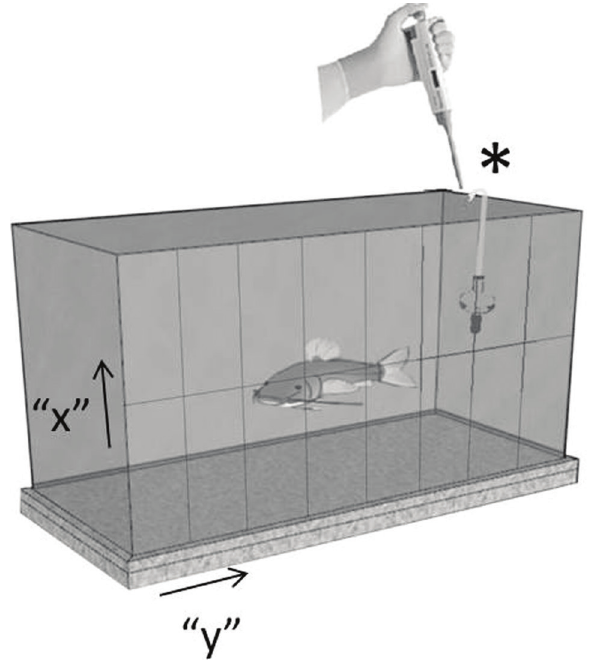
Fig. 1. Schematic drawing of the tank used for behavioral analysis of R. quelen , indicating the axes of evaluation of locomotory activity (arrows, “x” and “y”) and the location of the aeration stone and placement of alarm substance